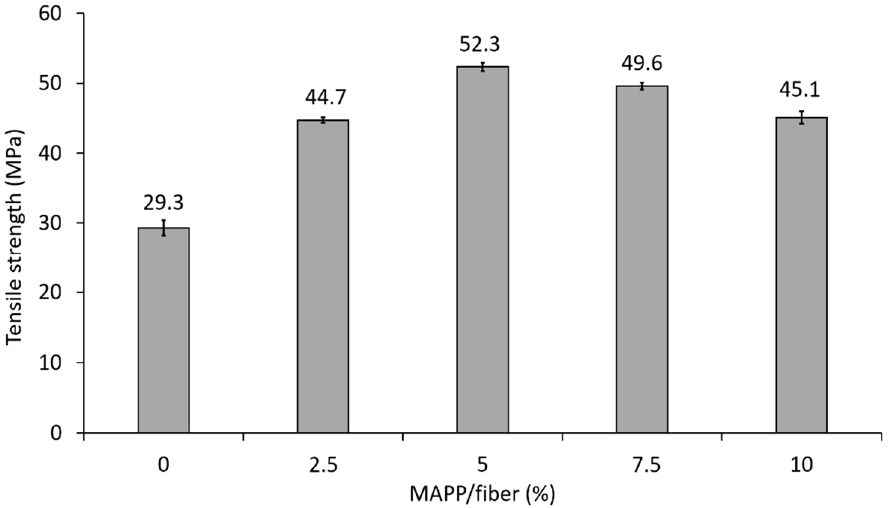
Figure 3. Tensile strength of composites reinforced at 40 wt.% of DPF-E and di ff erent MAPP contents.